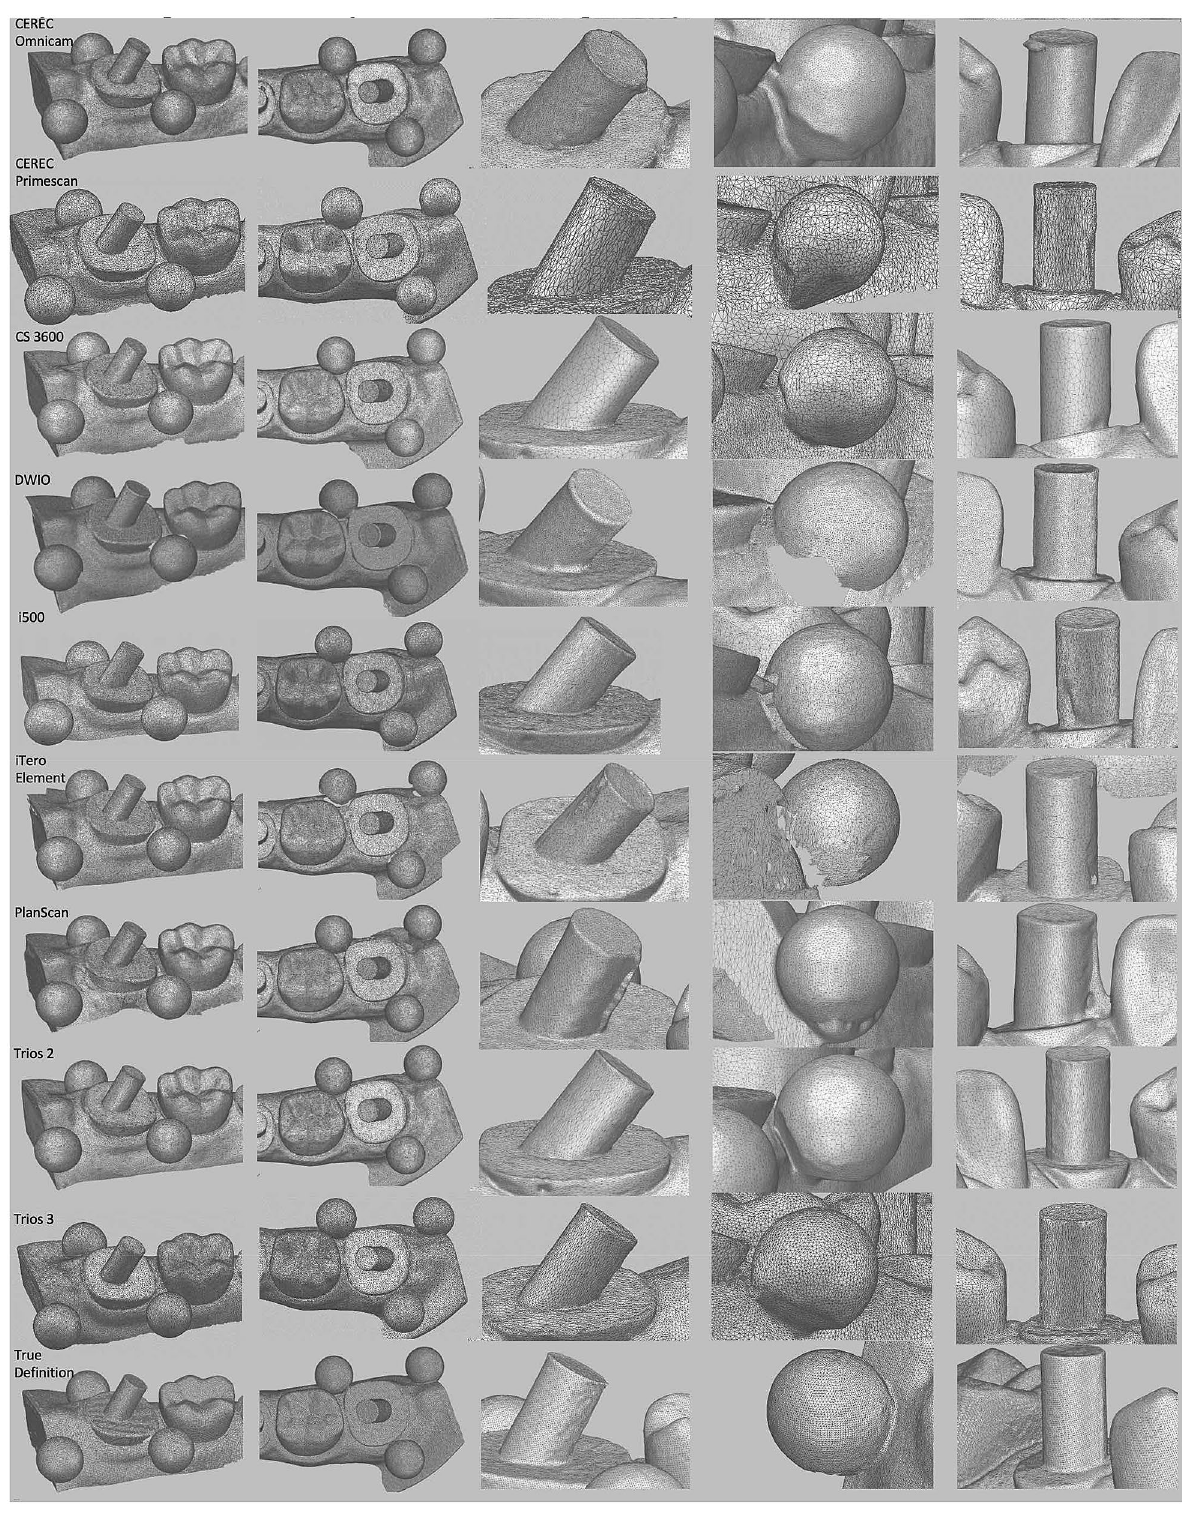
Figure 3. Representative digital models corresponding to master